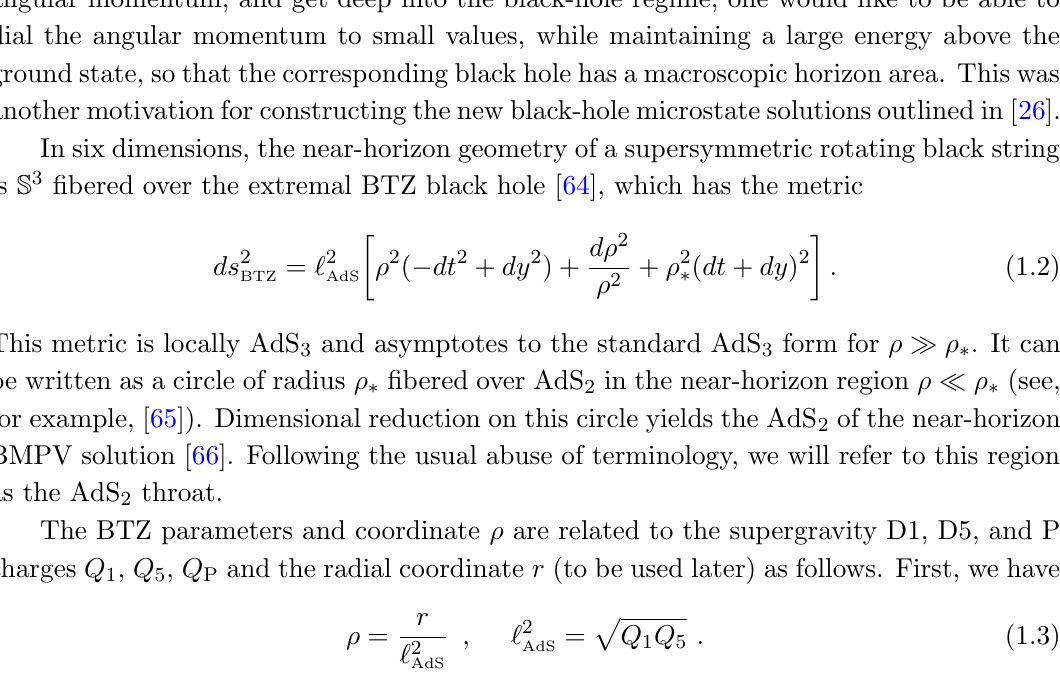
Figure 1 . Phase diagram for the spectrum in the RR sector; note that c = 6 N . Generic states above the cosmic censorship bound, i.e. with c charges as a black hole with rotation on the S 3 ; states below this bound (depicted in blue) are not. The 1/2-BPS supertube states (on the red line) all lie at or below the bound. energy available to generate black hole entropy, and takes one closer to a solution with a naked